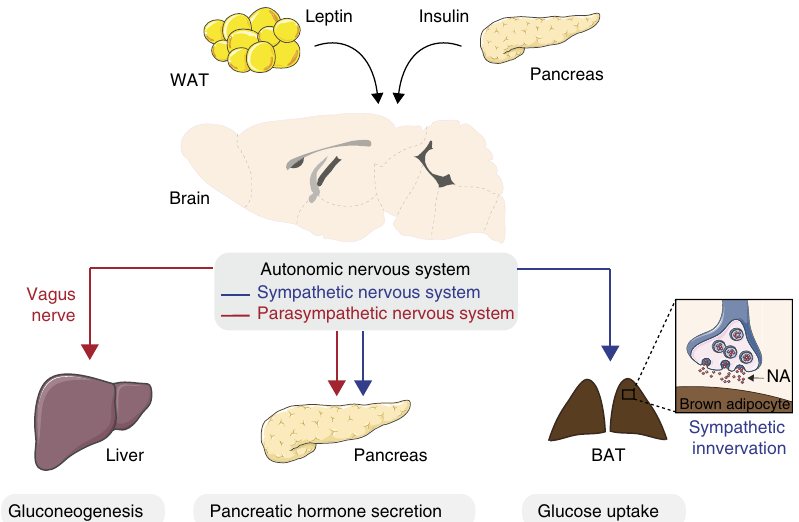
Figure 3 | Pathways involved in the control of glucose homeostasis. The central nervous system contains high density of receptors for the white adipose tissue (WAT)-derived hormone leptin as well as receptors for the pancreatic hormone insulin. Leptin and insulin act on specific brain regions that will in turn modulate glucose utilization and production in peripheral tissue via the autonomic nervous system. Notably, the vagus nerve links brain insulin action and the liver in the control of hepatic gluconeogenesis. At the pancreatic level, the autonomic nervous system is involved in pancreatic hormone secretion. The brown adipose tissue (BAT) receives sympathetic innervation which activity directly control BAT glucose uptake. NA,